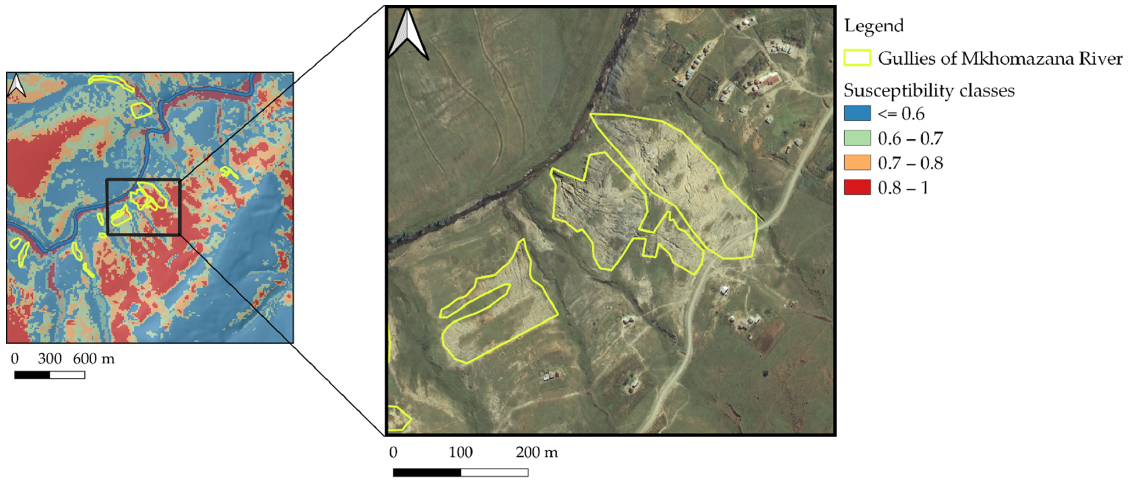
ISPRS Int. J. Geo-Inf. 2021 , 10 , x FOR PEER REVIEW Figure 10. Gullies of the Mkhomazana River used for external model validation. Figure 10. Gullies of the Mkhomazana River used for external model validation.